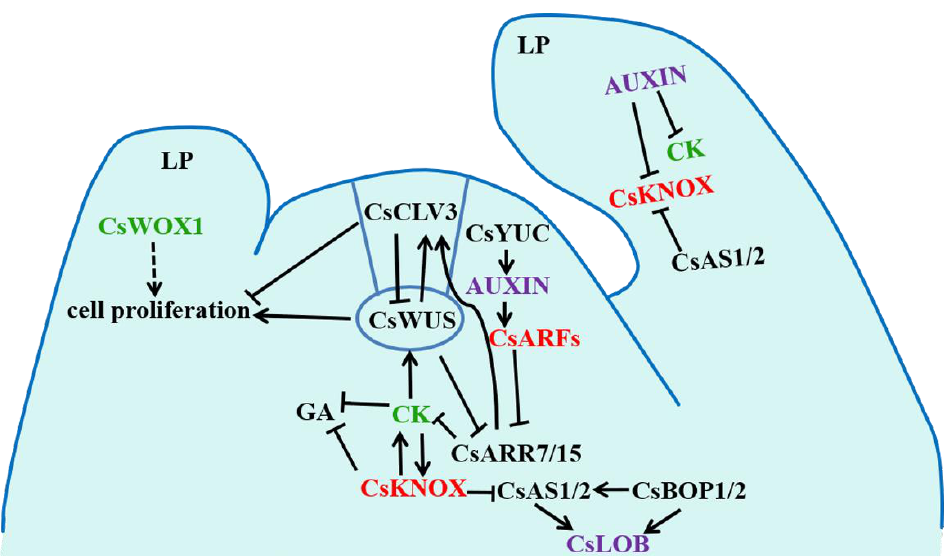
Figure 21. Model diagram of expression changes of growth and developmental regulatory genes and proteins in odd1 vs. WT. Red indicates up-regulation in odd1 vs. WT; green indicates down-regulation in odd1 vs. WT; and purple indicates both up-regulated and down-regulated genes in odd1 vs. WT.